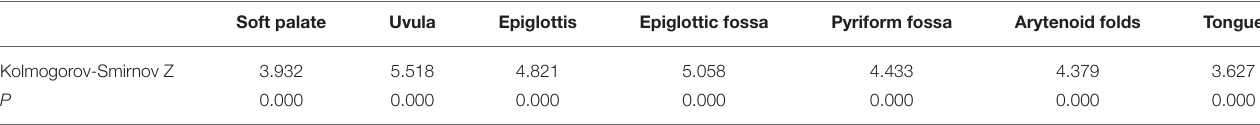
TABLE 2 | The anatomy of the pharynx between the tongue-out group and the non-tongue-out group (The Kolmogorov-Smirnov test).